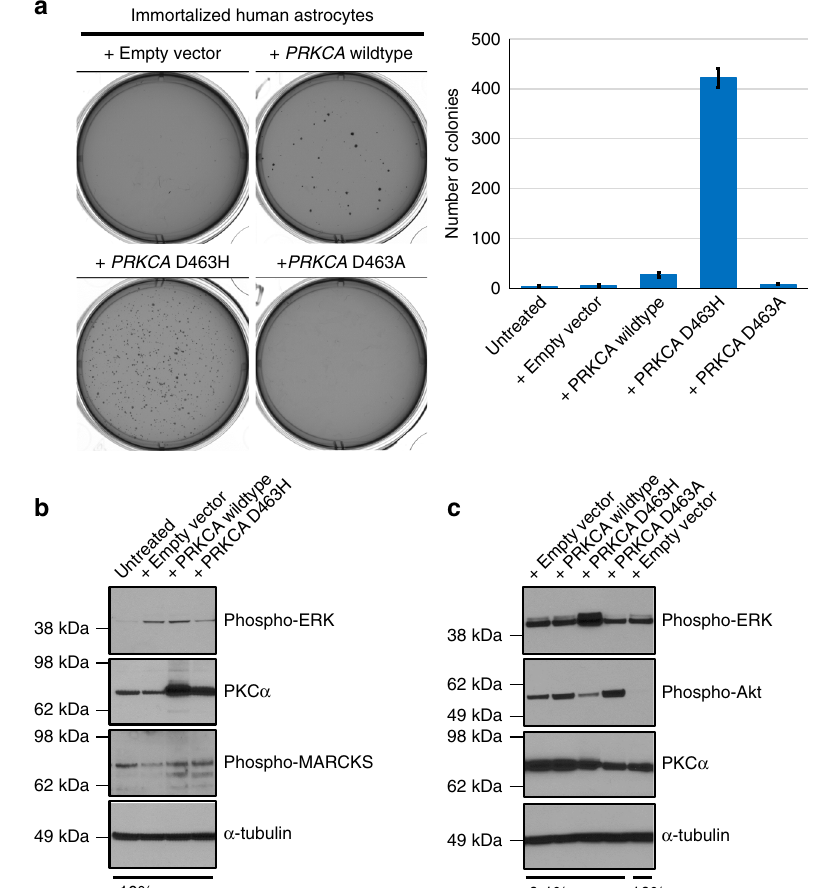
Fig. 2 Mutant PRKCA induces ERK phosphorylation and is suf fi cient to drive anchorage-independent growth of immortalized human astrocytes. a Colony formation in soft agar of immortalized human astrocytes after infection with lentivirus expressing empty vector, wildtype PRKCA , D463H tumor mutant PRKCA , or D463A non-tumor mutant PRKCA . Images of representative wells (left) and quantitation of colony number per well (right) are shown. Error bars represent standard deviation from the mean of six replicates derived from two independent experiments performed in triplicate. b Western blots on total cell lysate from 293 T cells growing in 10% fetal bovine serum after transient transfection with empty vector, PRKCA wild-type, or PRKCA D463H mutant. c Western blots on immortalized human astrocytes after lentiviral transduction and then serum starvation for 24 h before collection of total cell